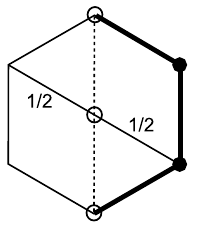
Figure 10 . Resolving ambiguities at the border of hexagons.